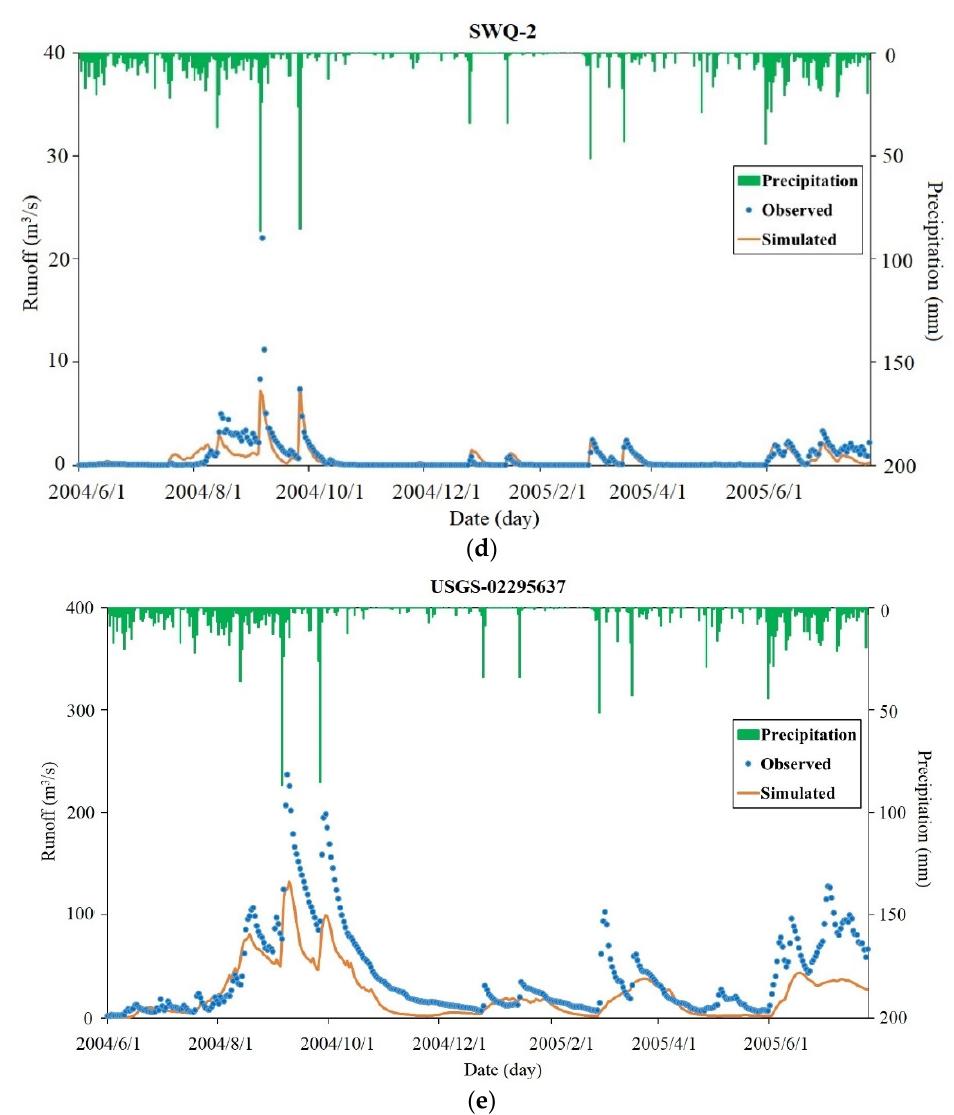
Figure 6. Daily runoff simulation of the five sites ( a ) SW-4, ( b ) SW-6, ( c ) SWQ-4, ( d ) SWQ-2, and ( e ) USGS-02295637. Table 9. Evaluation indexes of the daily runoff simulation results of the five sites.